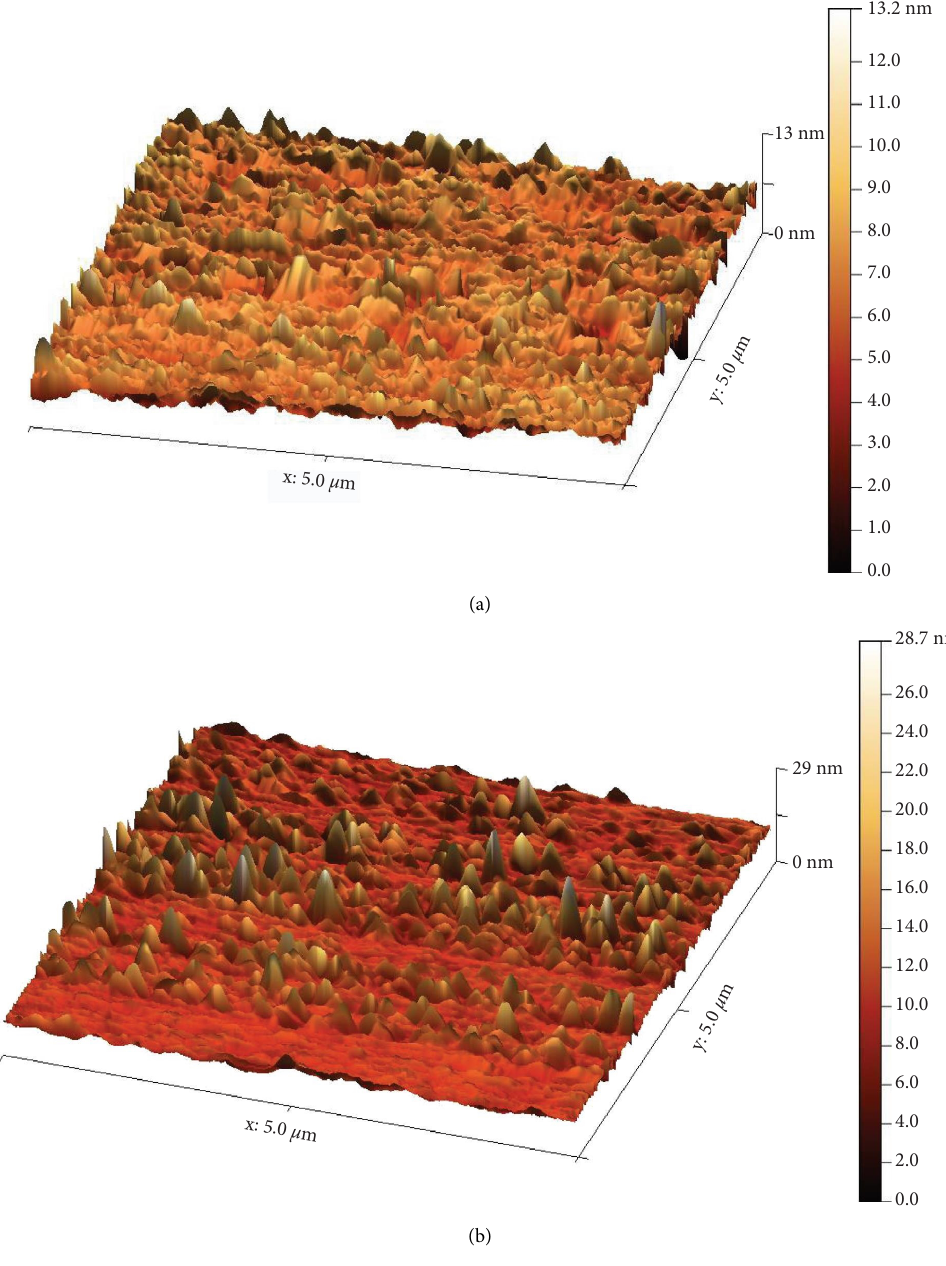
Figure 7: AFM picture of (a) PEEK/SiO